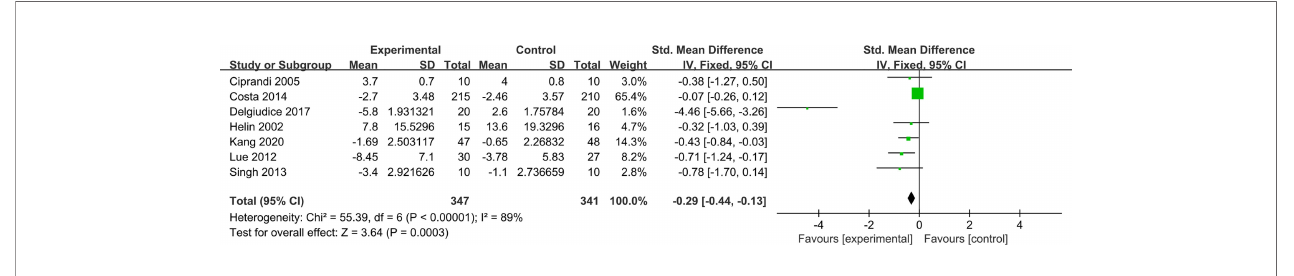
FIGURE 4 | Forest plot for allergic rhinitis symptoms